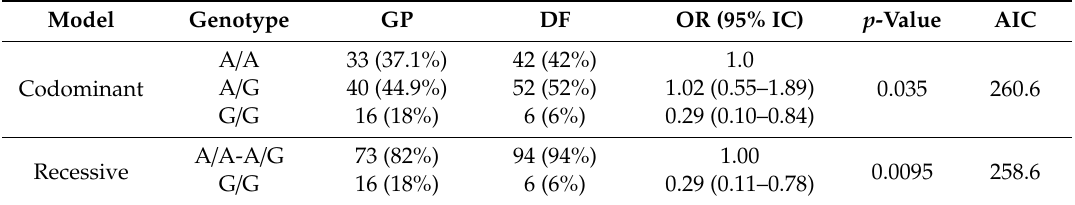
Table 4. Association of TLR4 -rs2737190 with the response group (DF) ( n = 189).